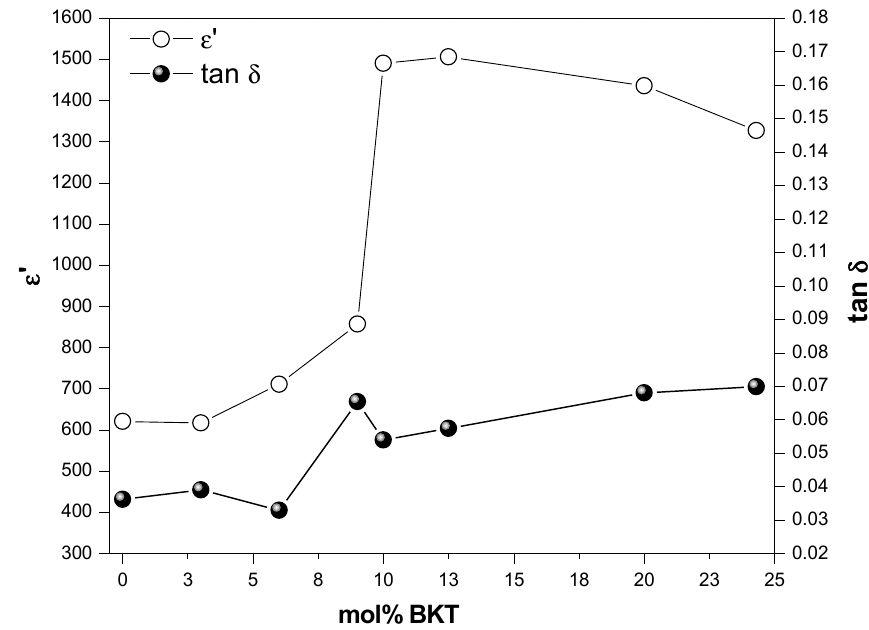
Figure 6. Dielectric properties of the prepared samples measured at 1 kHz and room temperature as a function of mol % BKT.